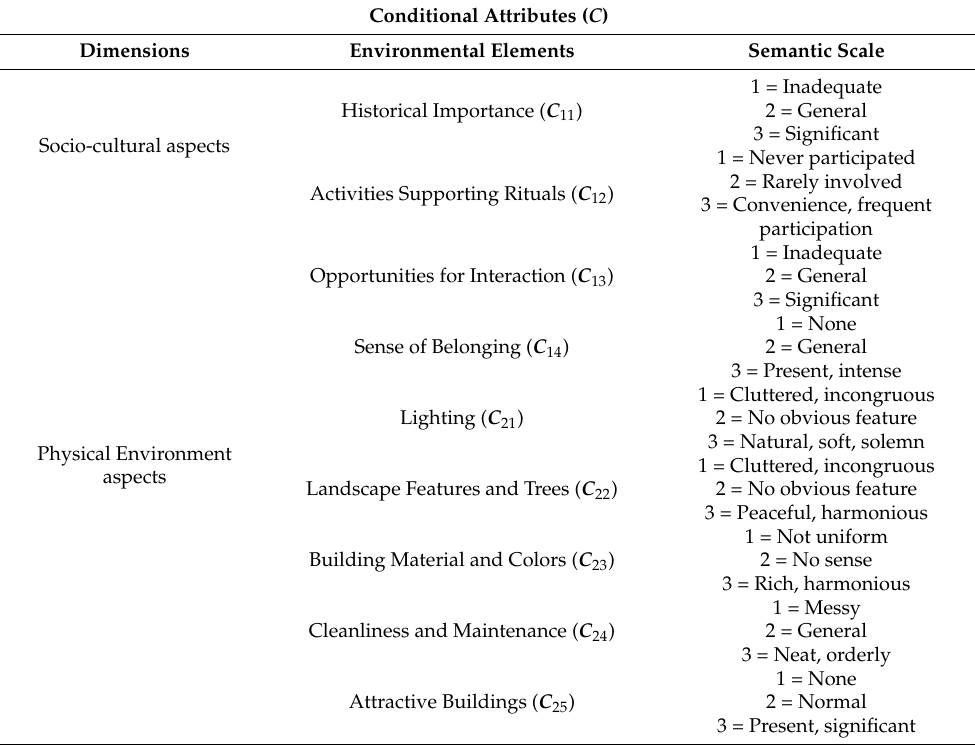
Table 2. Conditional attributes and semantic